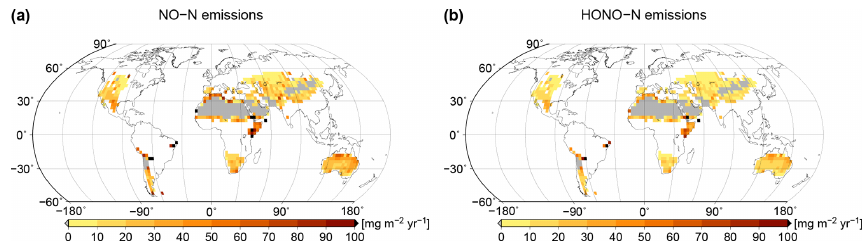
Figure 7. Global patterns of (a) NO and (b) HONO emissions simulated by LiBry, in units of milligrams of nitrogen per metre squared per year. White areas denote excluded regions, while grey areas correspond to regions where no simulated strategies are able to survive.